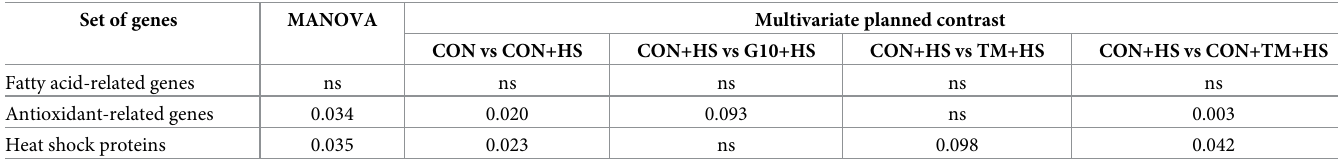
The treatments are described as follows: CON, chicks hatched from control eggs without in ovo injection and incubated at standard temperature; CON+HS, chicks hatched from control eggs without in ovo injection, incubated at standard temperature but exposed to HS; G10+HS, chicks hatched from eggs injected at 17.5 days of incubation with 0.6mL of 10% GABA dissolved in distilled water and exposed to HS; TM+HS, chicks hatched from thermally manipulated eggs exposed to 39.6˚C for 6 h daily from ED 10 to 18 and exposed to HS; G10+TM+HS, chicks hatched from eggs that received both previous treatments during incubation and exposed to HS. Data show mean ± SEM (n = 5). The Wilks’ Lambda P-values are reported. Abbreviation: ns, not significant.